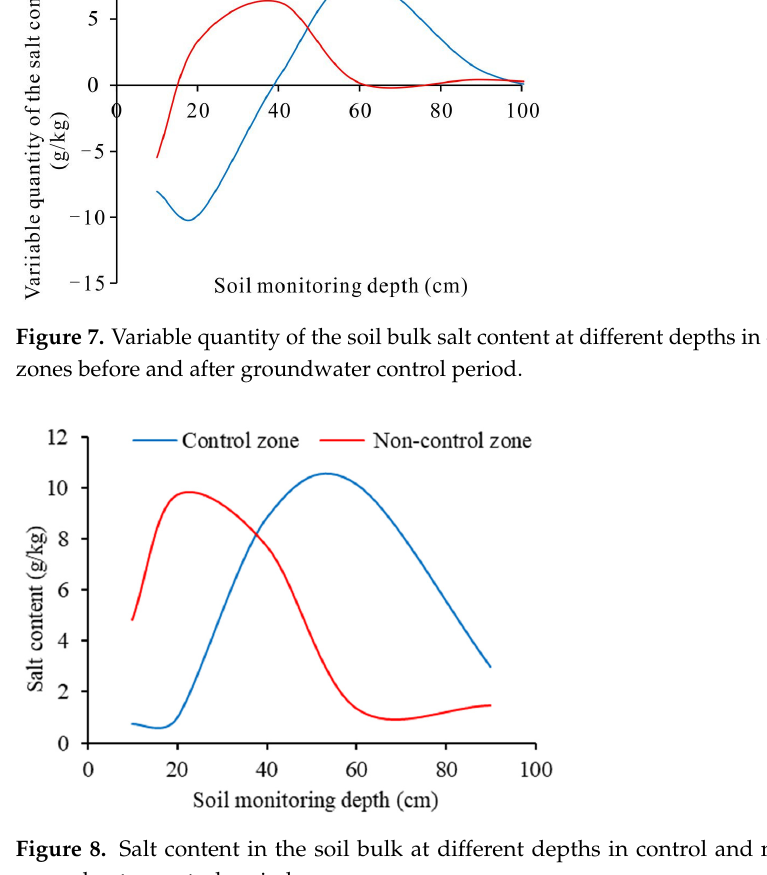
Figure 8. Salt content in the soil bulk at di ff erent depths in control and non-control zones after groundwater control period. groundwater control